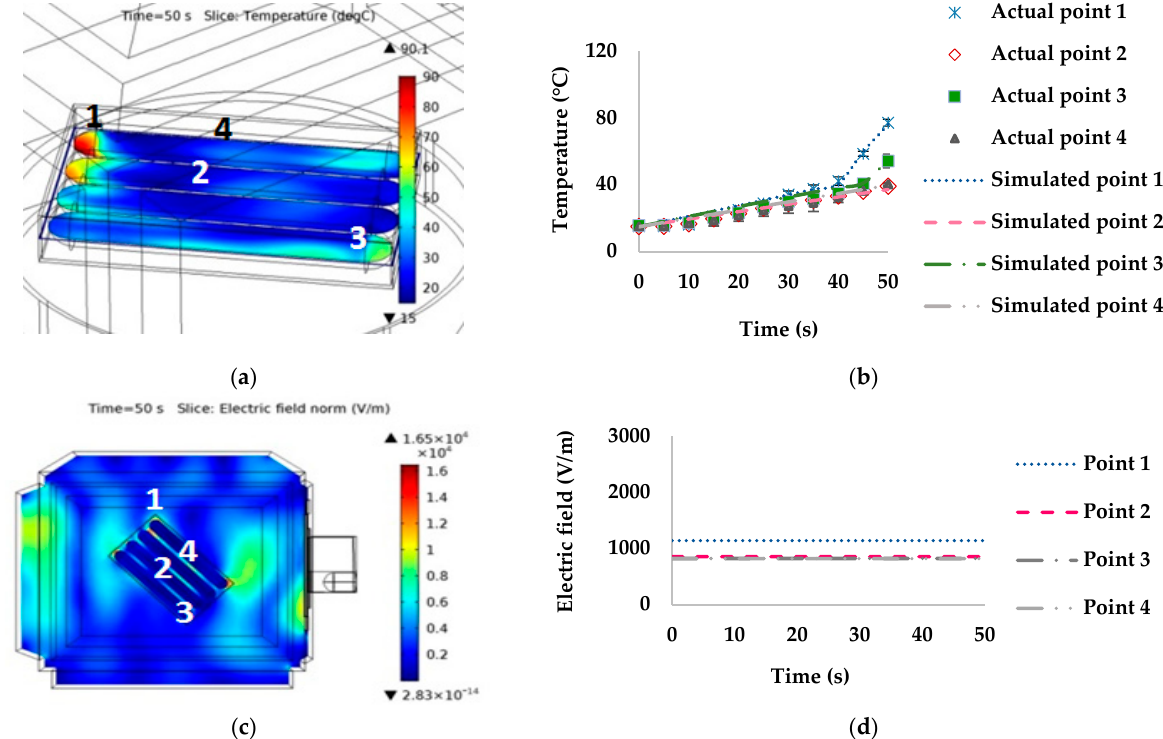
Figure 7. Effect of simulated stationary microwave on ( a ) thermal simulation, ( b ) temperature profile at points 1–4, ( c ) electric field, and ( d ) electric field profiles at points 1–4 of ready-to-eat sausage at 45° orientation to waveguide.